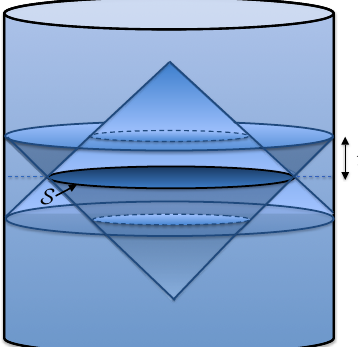
Figure 1 . A large causal diamond in AdS consisting of the domain of dependence of the ball bounded by the holographic screen . The ball and the screen lie in the t = 0 time slice, and are S centered around the origin. The distance of to the AdS boundary can be characterized by the S time t at which the outward future lightsheet reaches the AdS